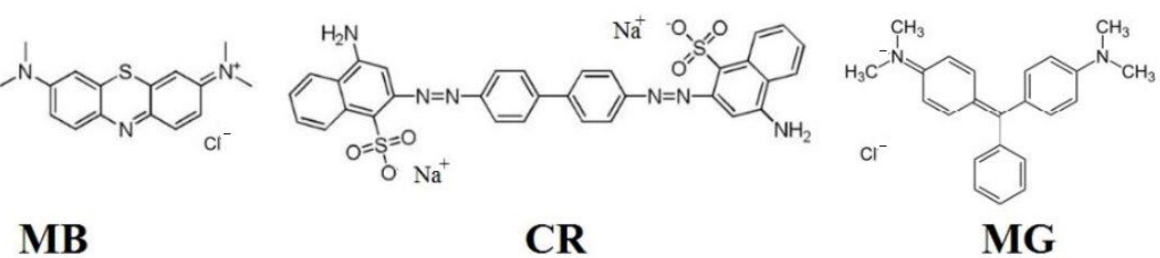
Figure 1. Formulas of Congo red (CR), methylene blue (MB), and malachite green (MG).